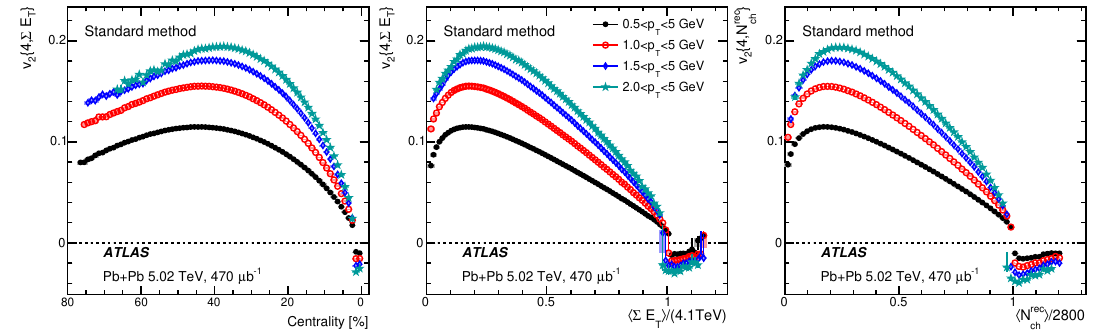
Figure 21 . The v 2 f 4 g values calculated for charged particles in four p T ranges as a function of centrality (left panel), (cid:6) E T (middle panel), and N rec boxes represent the statistical and systematic uncertainties, respectively. Zero is indicated by a dotted line.